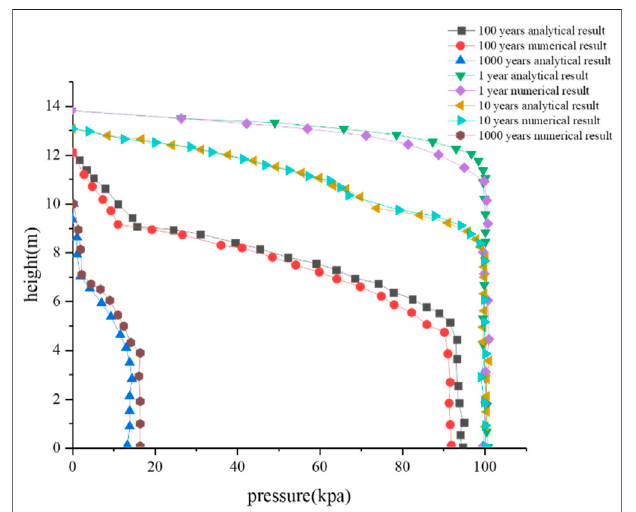
FIGURE 10 | Overpressure evolution comparison of numerical and analytical results for the three layers with different properties for 1, 10, 100, and 1,000 years.